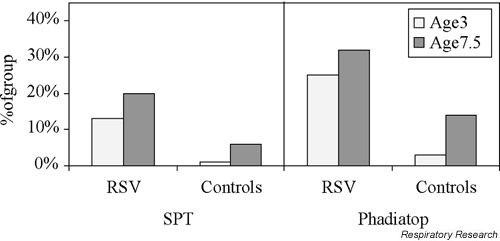
Allergic sensitization up to age 7.5 years in 44 children with respiratory syncytial virus (RSV) bronchiolitis in infancy and 89 control children. Phadiatop® (Pharmacia Diagnostics, Uppsala, Sweden) is a screening test for serum IgE antibodies to inhaled allergens. SPT, skin prick test. Reproduced with permission from Sigurs et al.[14].